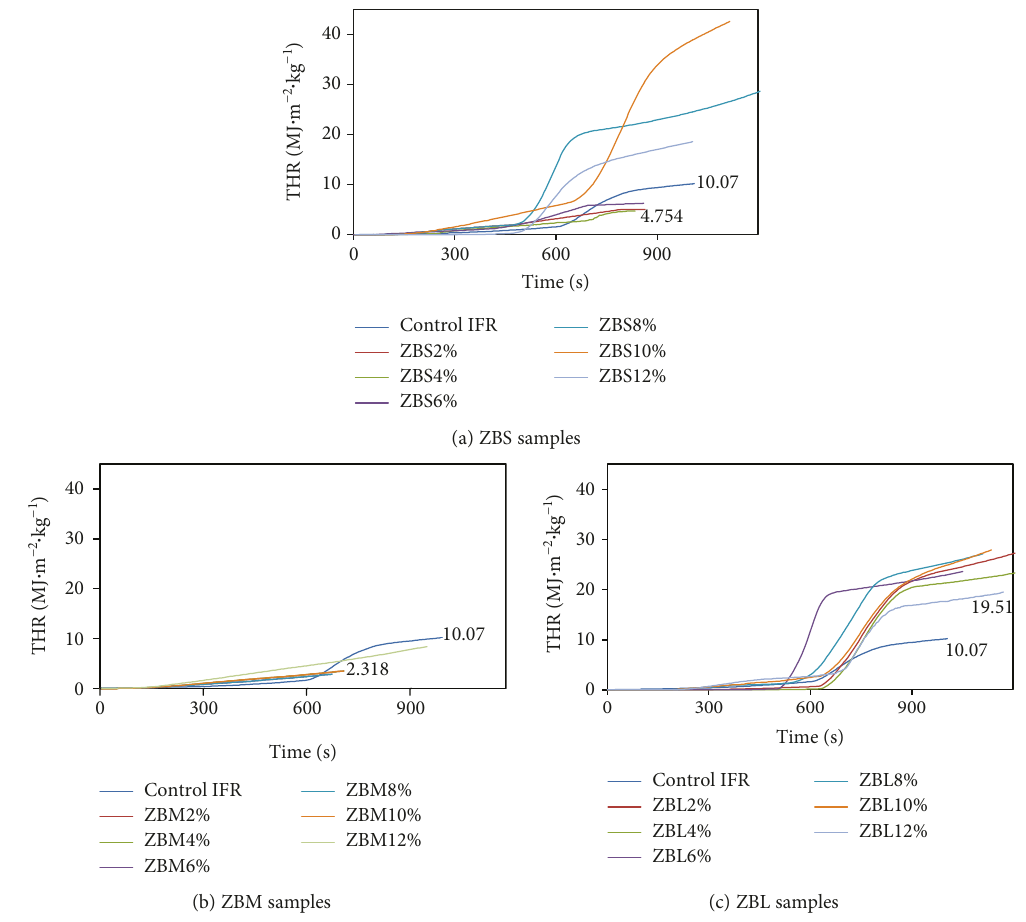
Figure 2: Total heat release of wood treated with IFR/ZB